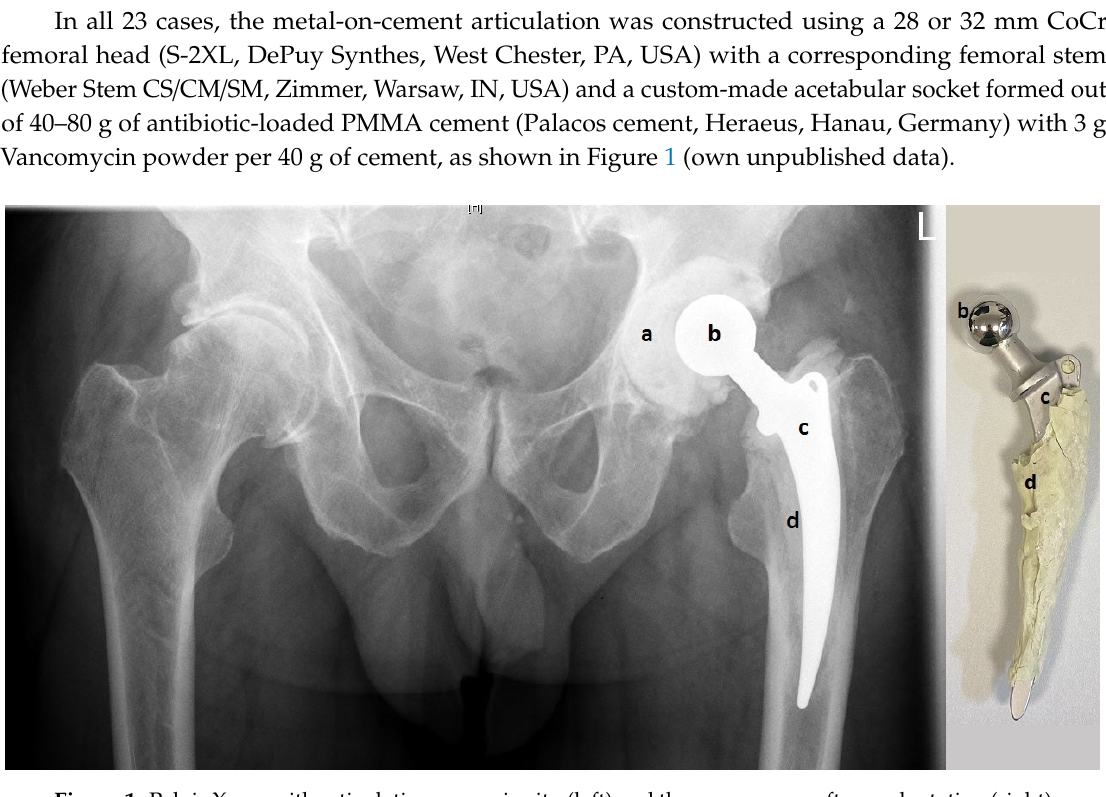
Figure 1. Pelvic X-ray with articulating spacer in situ (left) and the same spacer after explantation (right). The custom-made acetabular socket ( a ) is made of antibiotic-loaded PMMA (polymethylmethacrylate) bone cement and creates the metal-on-cement articulation with the CoCr femoral head ( b ). PMMA bone cement ( d ) is also used to fix the femoral stem into the femur ( c ).